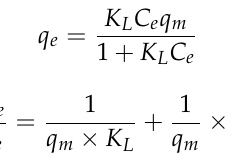
Table 1. Langmuir and Freundlich parameters for the adsorption of cationic dyes onto MSNs at 25 °C. Dyes